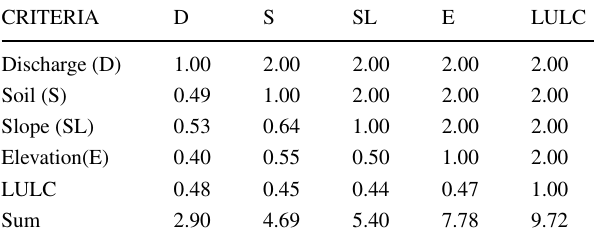
Table 7 Pairwise comparison matrix for dam suitable assessment based on the expert’s opinion CRITERIA